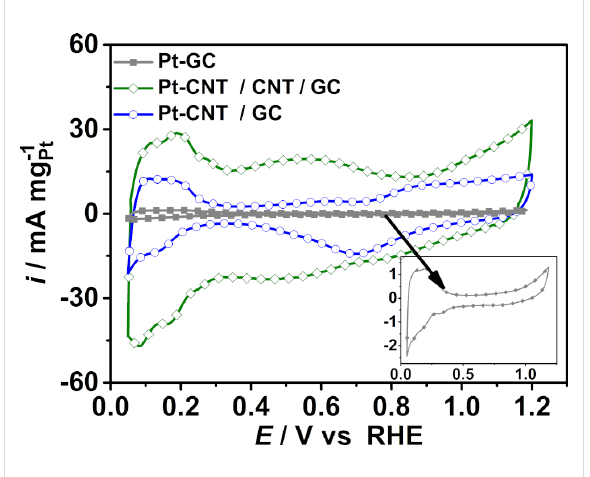
Figure 8: Cyclic voltammograms of Pt on GC, CNT/GC and CNT/ CNT/GC electrodes recorded at a scan rate of 100 mV s − 1 at room temperature in a N 2 -purged aqueous 0.5 M H 2 SO 4 electrolyte